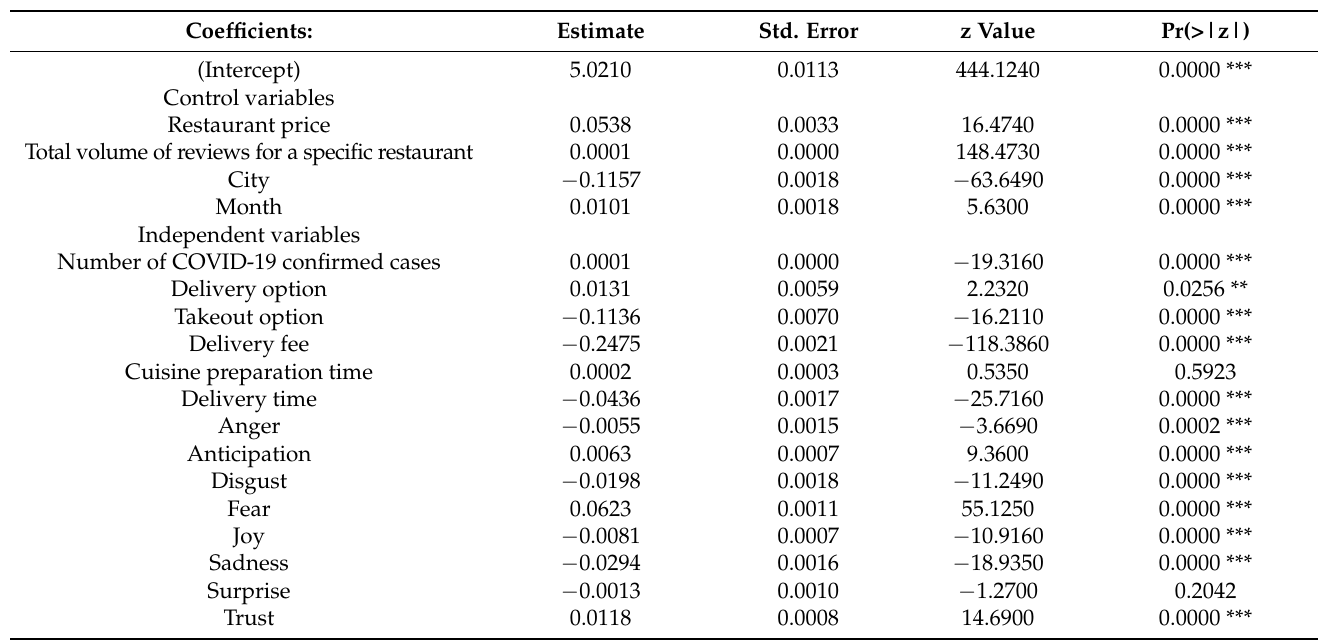
Table 3. Poisson regression